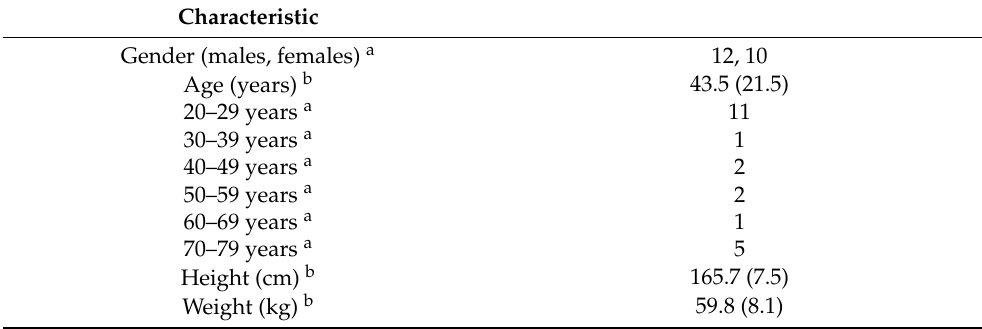
Table 1. Characteristics of study participants (n =